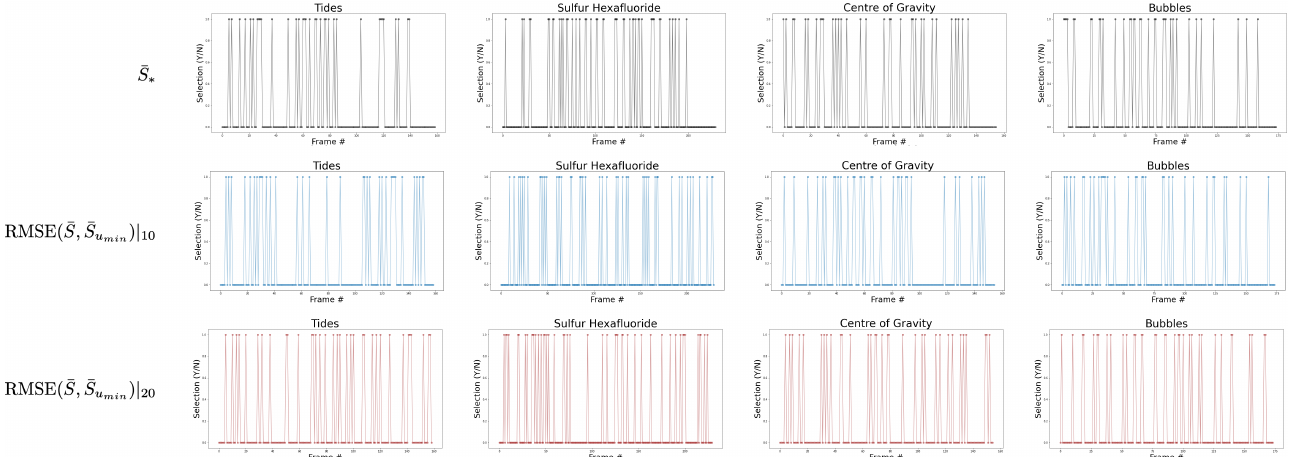
Figure 3. Comparison of distribution of selected frames for a subset of videos (Tides, Sulfur Hexaflu- oride, Centre of Gravity and Bubbles) using the method based on text-conditioned object detection and the baselines using the Signature